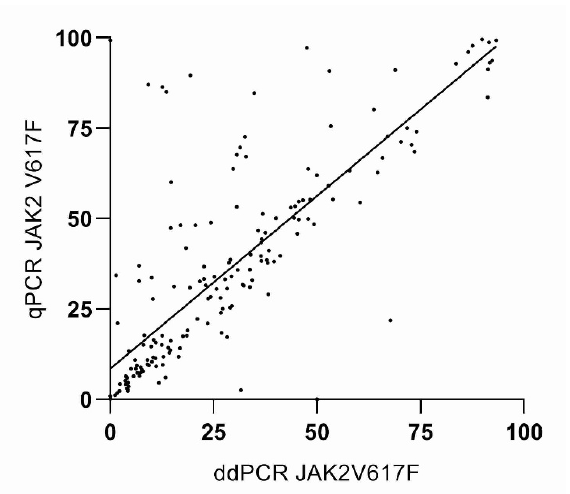
Figure 1. Log–log plot demonstrating the correlation of droplet digital CR (ddPCR) and qPCR JAK2 V617F mutation allele frequency quantification with NIBSC calibrators.